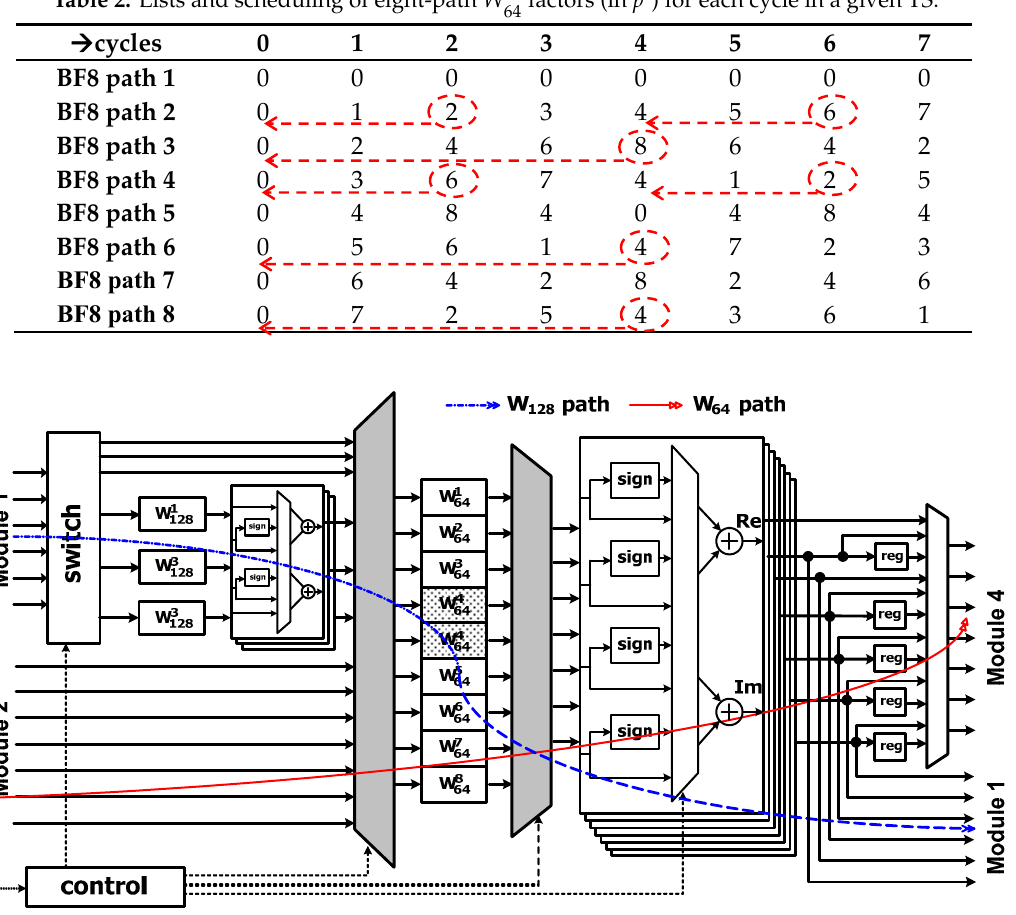
Table 2. Lists and scheduling of eight-path W p